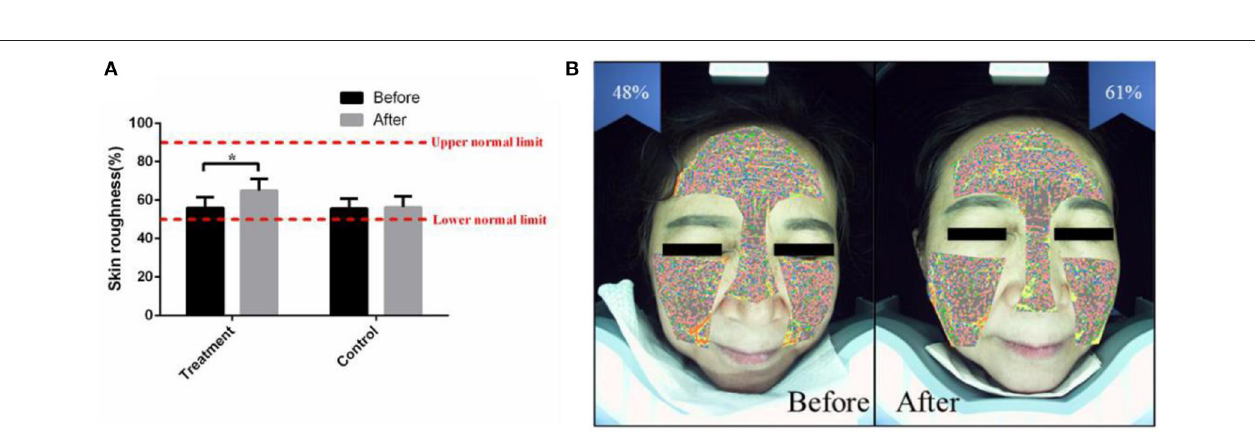
FIGURE 3 | The combined therapy decreased the red area in the treatment group. (A) The proportion of red area before and after treatment in the treatment group and control group. (B) Representative pictures of a 27-year-old female taken by intelligent facial detection in the treatment group, which shows the comparison between the red area values before and after treatment. The results are expressed as the mean ± SD. * p < 0.05.